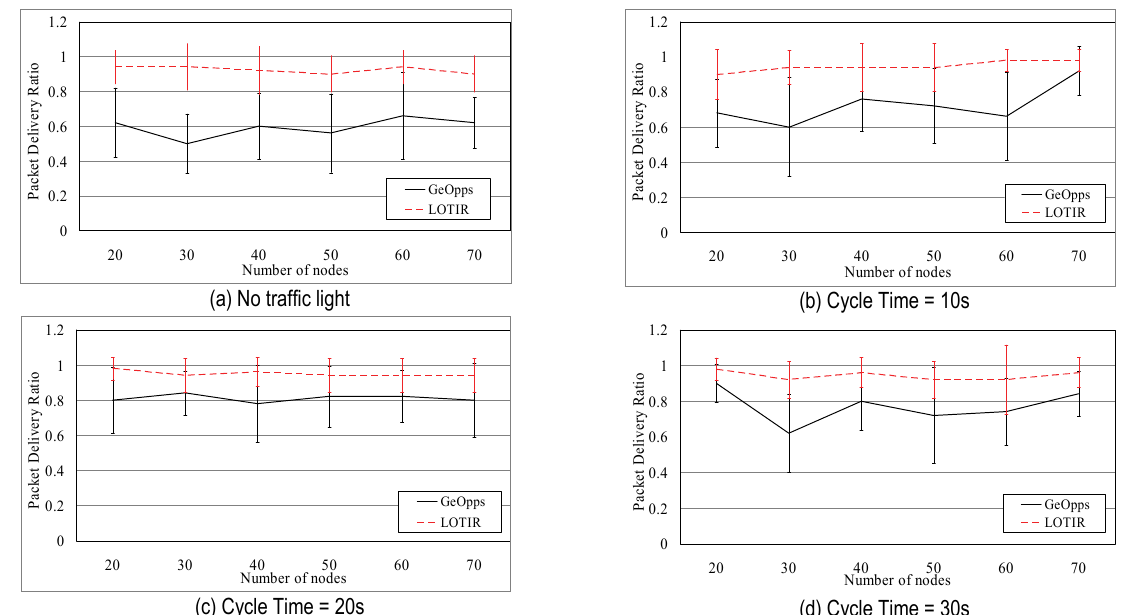
Figure 13. Packet delivery ratio for different cycle times and protocols in Pareto Figure 12. The snapshot of network topology when the number of nodes is 50